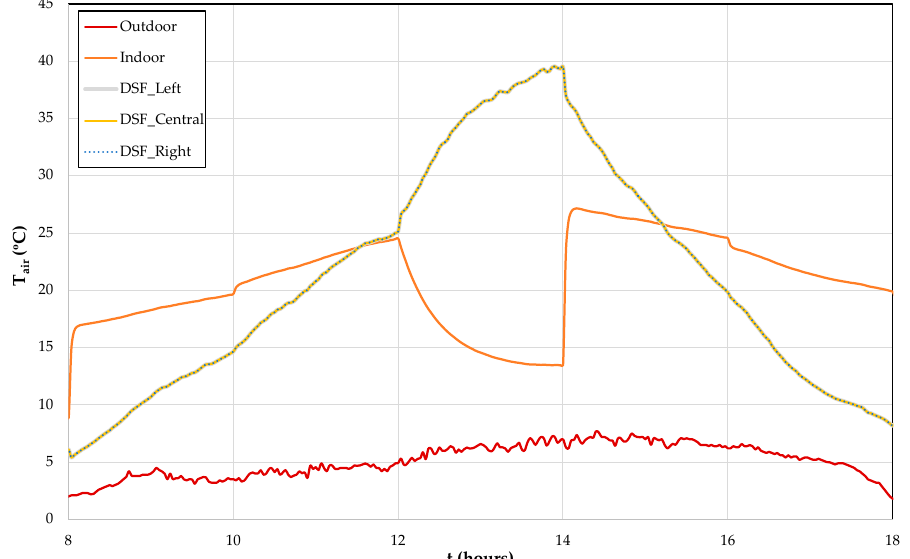
Figure 18. Evaluation of air temperature (T air ) of the outdoor environment, indoor virtual chamber and indoor left, central and right DSF system, when the airflow rate is variable and the number of DSFs to operate is constant, for the Case F.